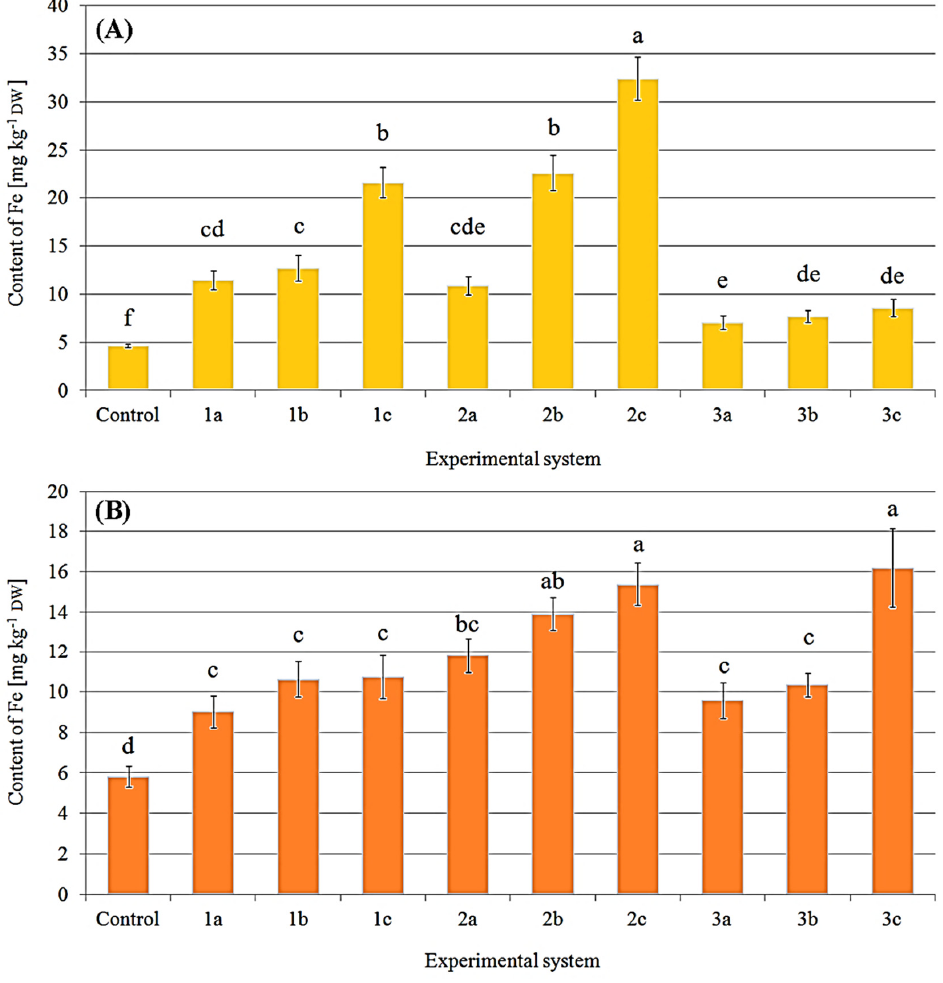
Figure 4. Content of Fe (mg kg -1 DW) in P. eryngii ( A ) and P. ostreatus ( B ) in the second crop exposed